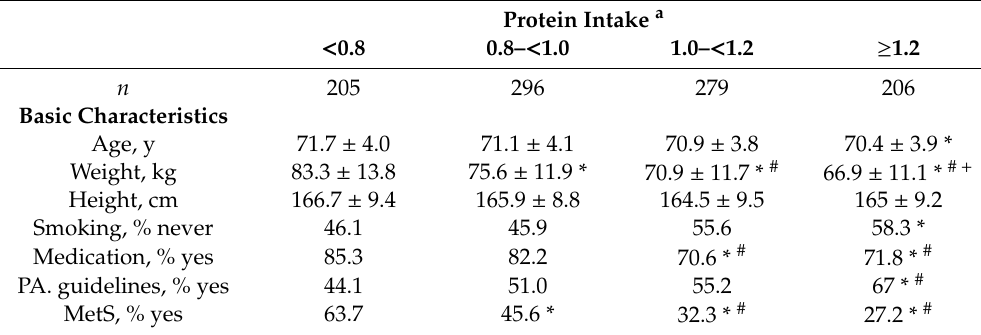
Table 1. General characteristics of the study population by groups of protein